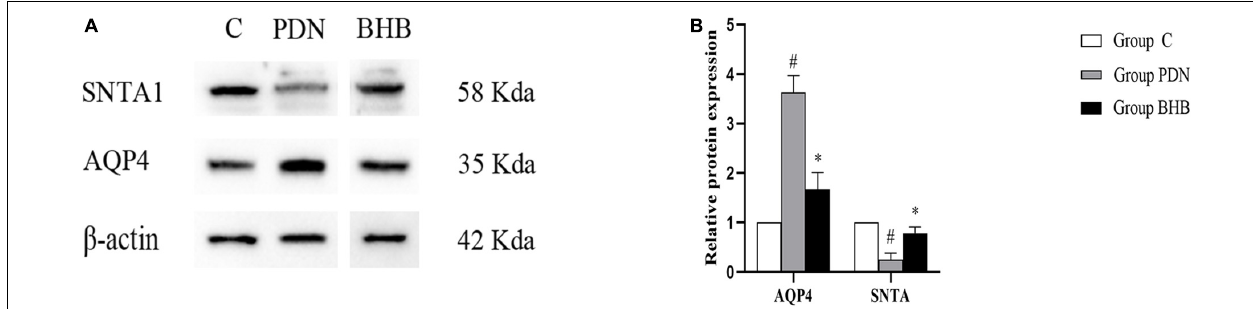
FIGURE 4 | Western blot results. (A) Western blot analysis of SNTA1 and AQP4 protein expression in Group C, Group PDN, and Group BHB. (B) Relative protein expression of SNTA1 and AQP4. Due to the reason that some blots in the original saved images were not mentioned in the present study, we spliced the blots and the typical ones were chosen to indicate the differences in the expression of proteins. Refer to Figure 1 for the meaning of the grouping abbreviation. Values were presented as mean ± SEM. ∗ p < 0.05 compared with values in Group PDN. # p < 0.05 compared with values in Group C. SNTA1 means α -syntrophin, and AQP4 means aquaporin-4 protein.